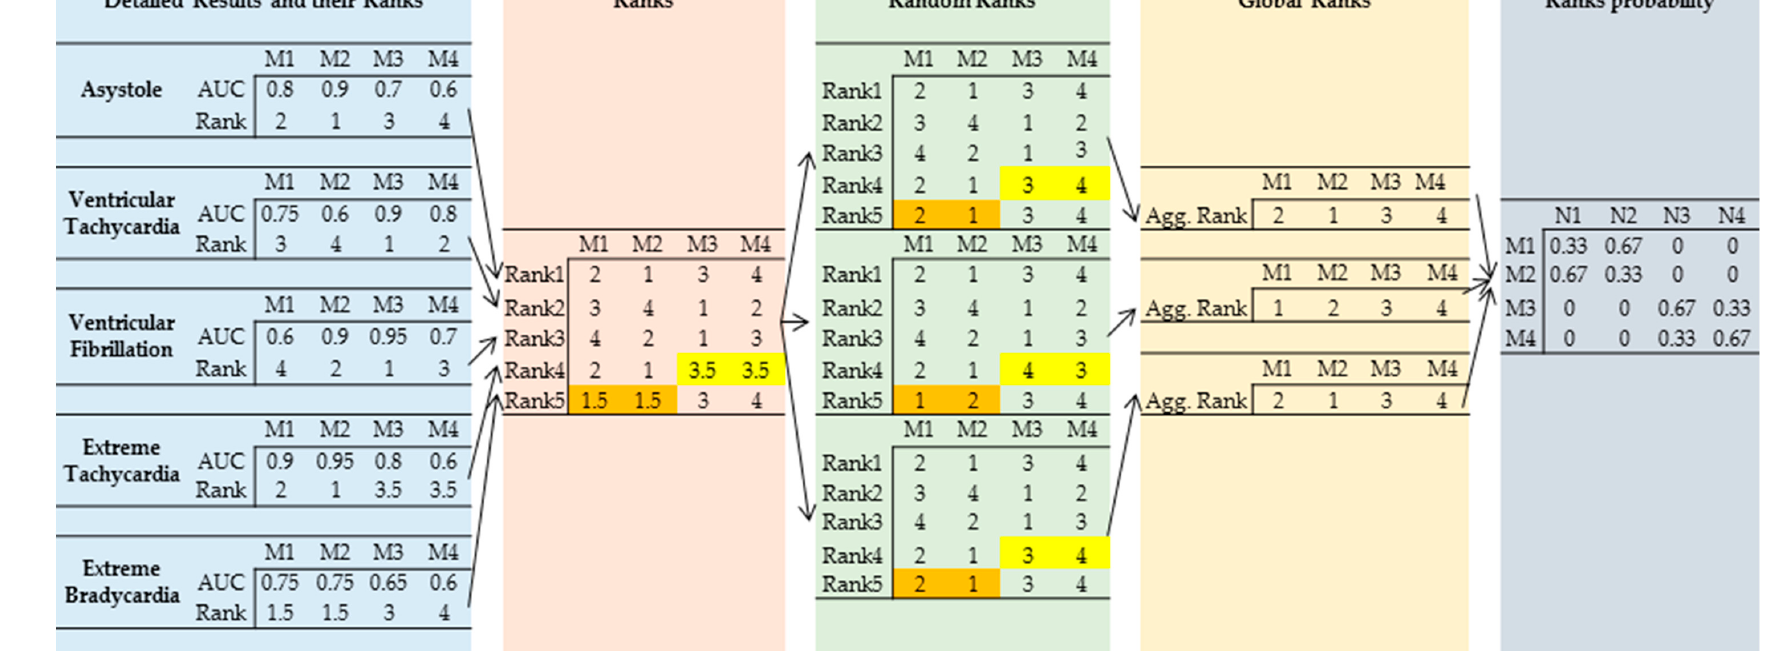
Figure A1. The approach to derive global ranks (N1–N4) for each method (M1–M4) for probability assignment and each arrhythmia type based on the AUC measure on the validation sample. Orange and yellow highlight the equal ranks; these were subject to 3-fold random rank